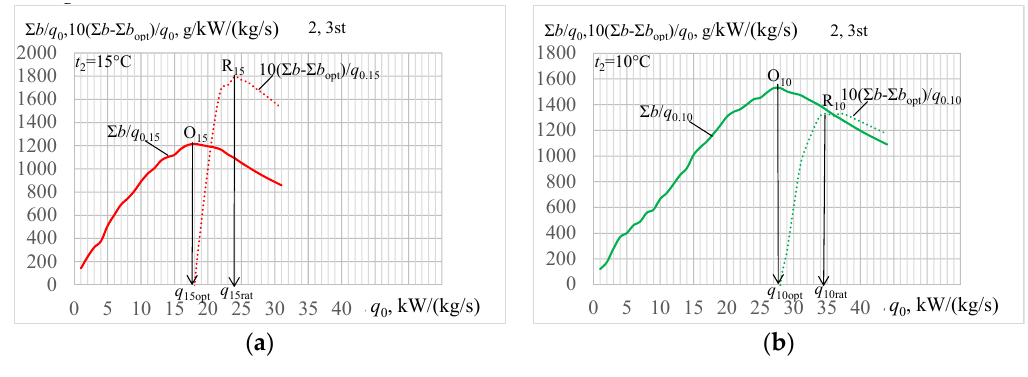
(cid:80) (cid:80) (cid:80) b / q 0 and ( b − b opt ) / q 0 for t a 2 =